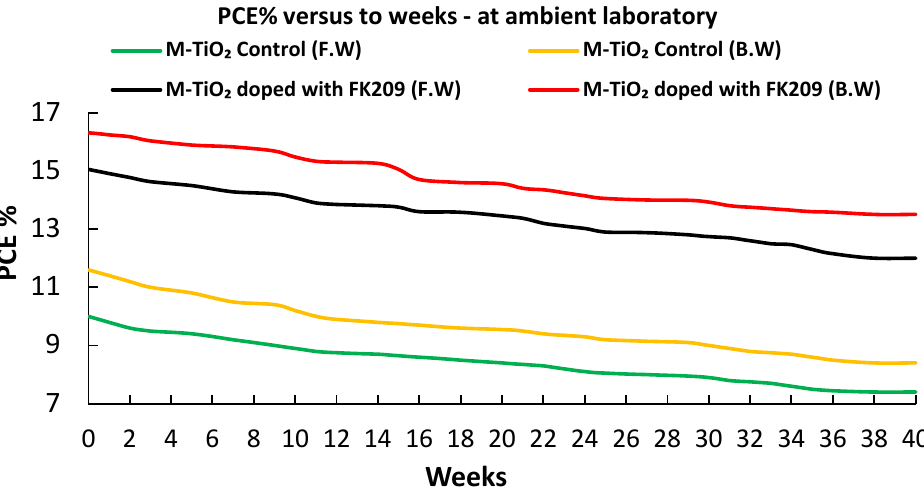
Figure 17. Device stability testing by measuring variations in the efficiency of the perovskite solar cells measured over 40 weeks period in weekly intervals. Devices were kept in ambient laboratory and tested under AM1.5, 100 mW/cm 2 illumination using ABET sunlight simulators with reference cell as a control.